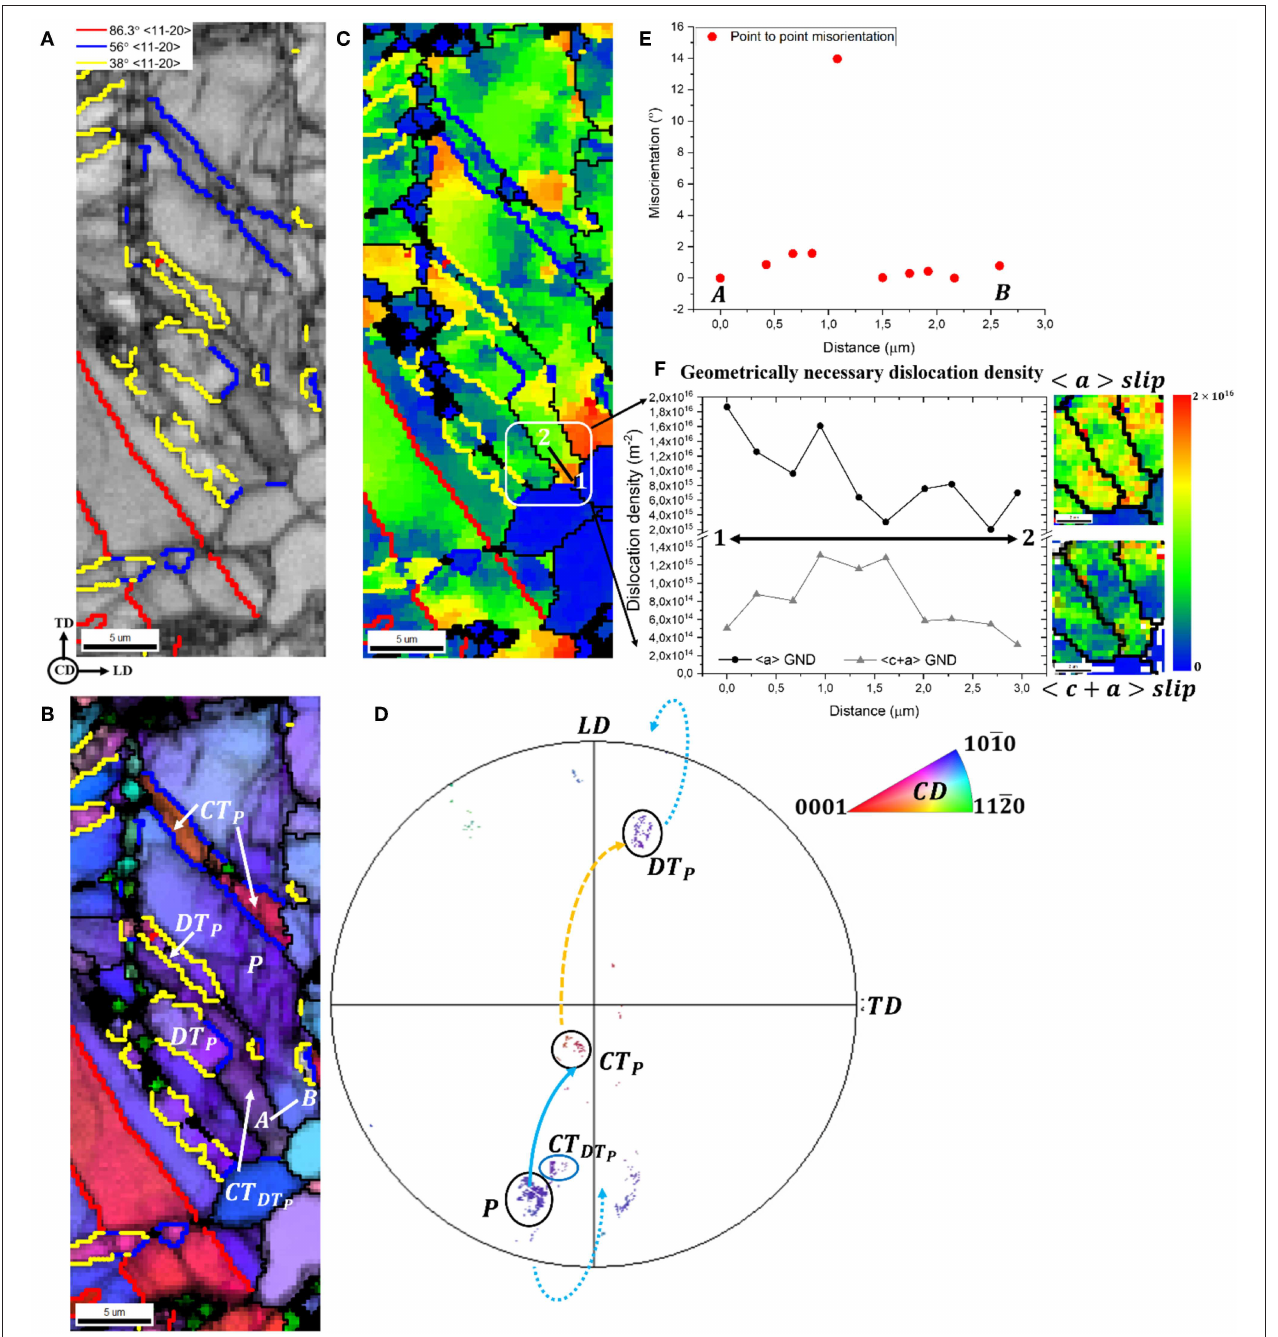
FIGURE 6 | (A) Image quality, (B) inverse pole figure, and (C) grain reference orientation deviation maps, showing formation of hierarchically twinned structures described by a { 1011 } compression twin nucleating inside { 1011 } − { 1012 } double twin. (D) Single orientation scatter data indicating the twin induced reorientations; (E) misorientation profile across the boundary (line AB) between the 3rd generation compression twin and the original parent grain; (F) geometrically necessary dislocation density gradients for < a > -type and < c + a > type slip near the grain boundary along line 1–2 are plotted as a function of distance; basal and pyramidal dislocation density maps are additionally shown to the right of the